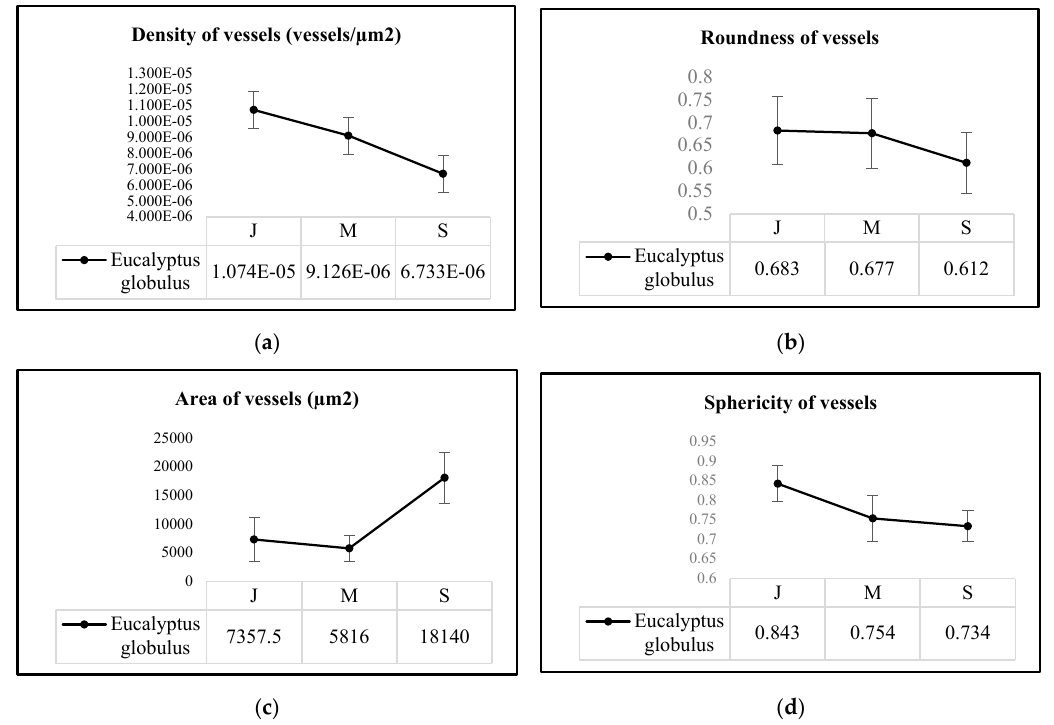
Figure 5. Average values of ( a ) density, ( b ) area, ( c ) roundness and ( d ) sphericity of vessel elements from Eucalyptus globulus tissue-microstructure per age group, i.e., juvenile (J), mature (M) and senile (S). A total of 385 longitudinal parenchyma cells (i.e., 98 juvenile, 131 mature and 156 senile) from the Eucalyptus globulus samples and 658 elongated lignified longitudinal tracheids (i.e., 233 juvenile, 250 mature and 175 senile) from the Cupressus macrocarpa samples were measured. The results of these − 10 analyses show a quasi-linear decrease in density ( p -value = 2.820 × 10 ) with a consequent